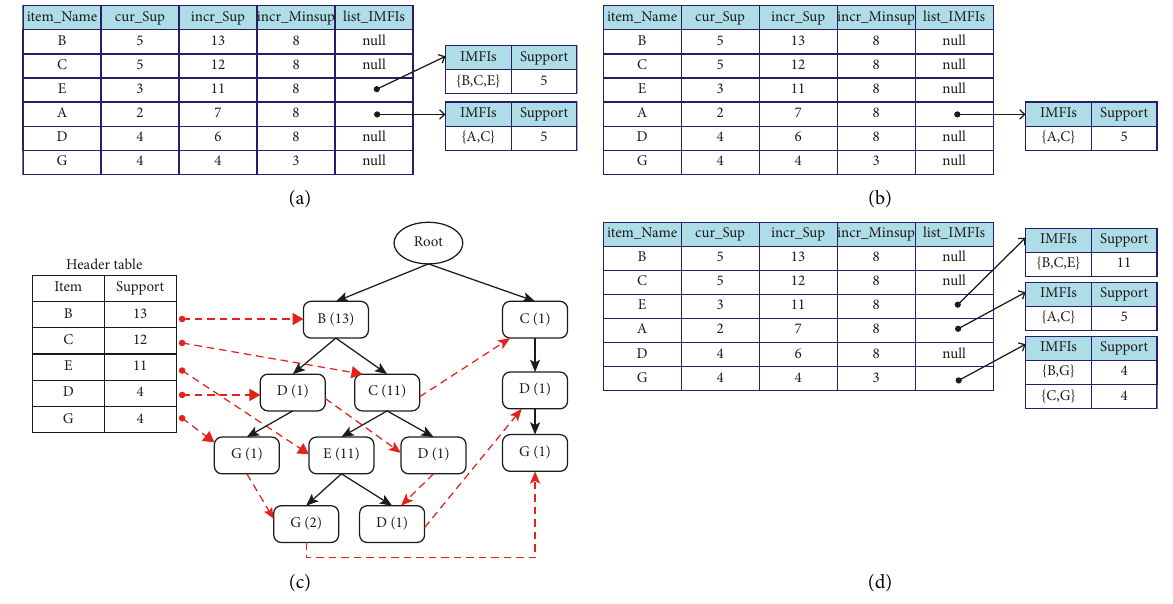
Figure 4: Example at T2. (a) P2 after phase 1, (b) P2 after phase 2, (c) tree as FP-tree after phase 2, and (d) P2 after phases 3-4. Table 9: Rules that have Conf 0.7 after phase 5 at ≥